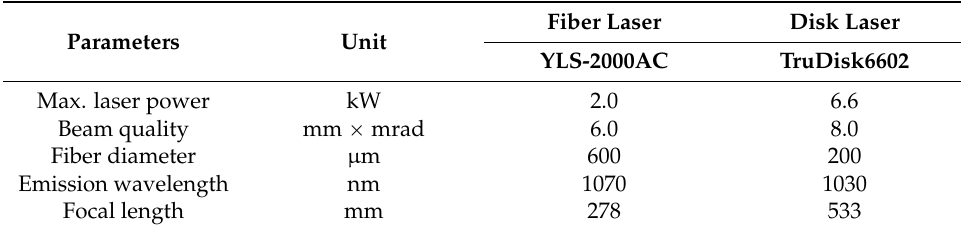
Table 2. Technical parameters of the laser welding systems.